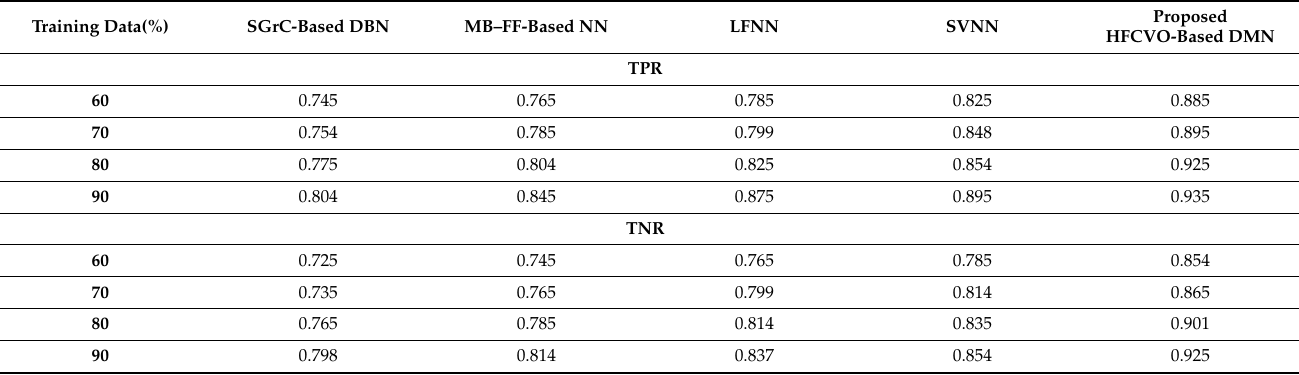
Table 5. Comparative analysis using Reuter dataset for TPR, TNR, FNR, precision, and testing